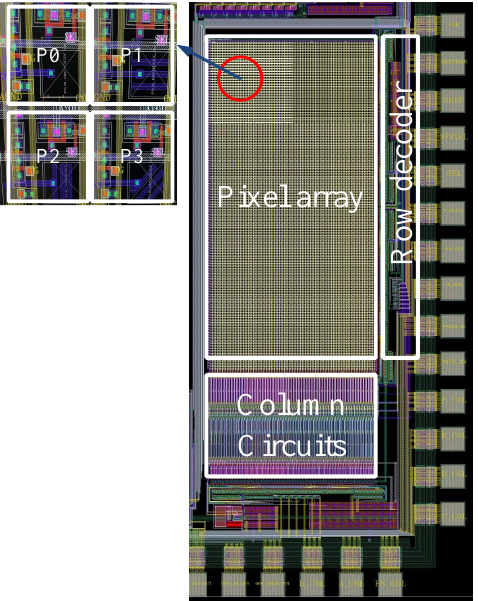
Figure 3. Microchip photograph showing pixels with wire grid polarizers.